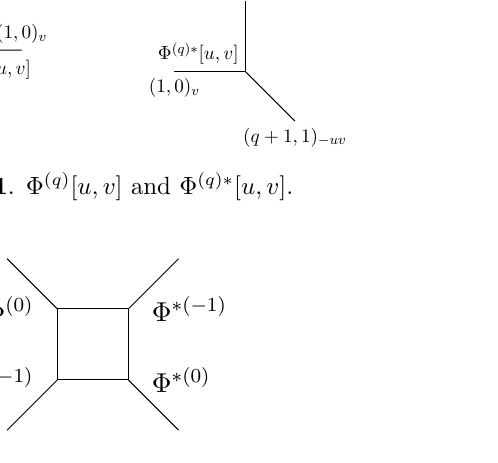
Figure 2 . The web diagram of 5d N = 1 pure SU(2) gauge theory and the assignment of topological